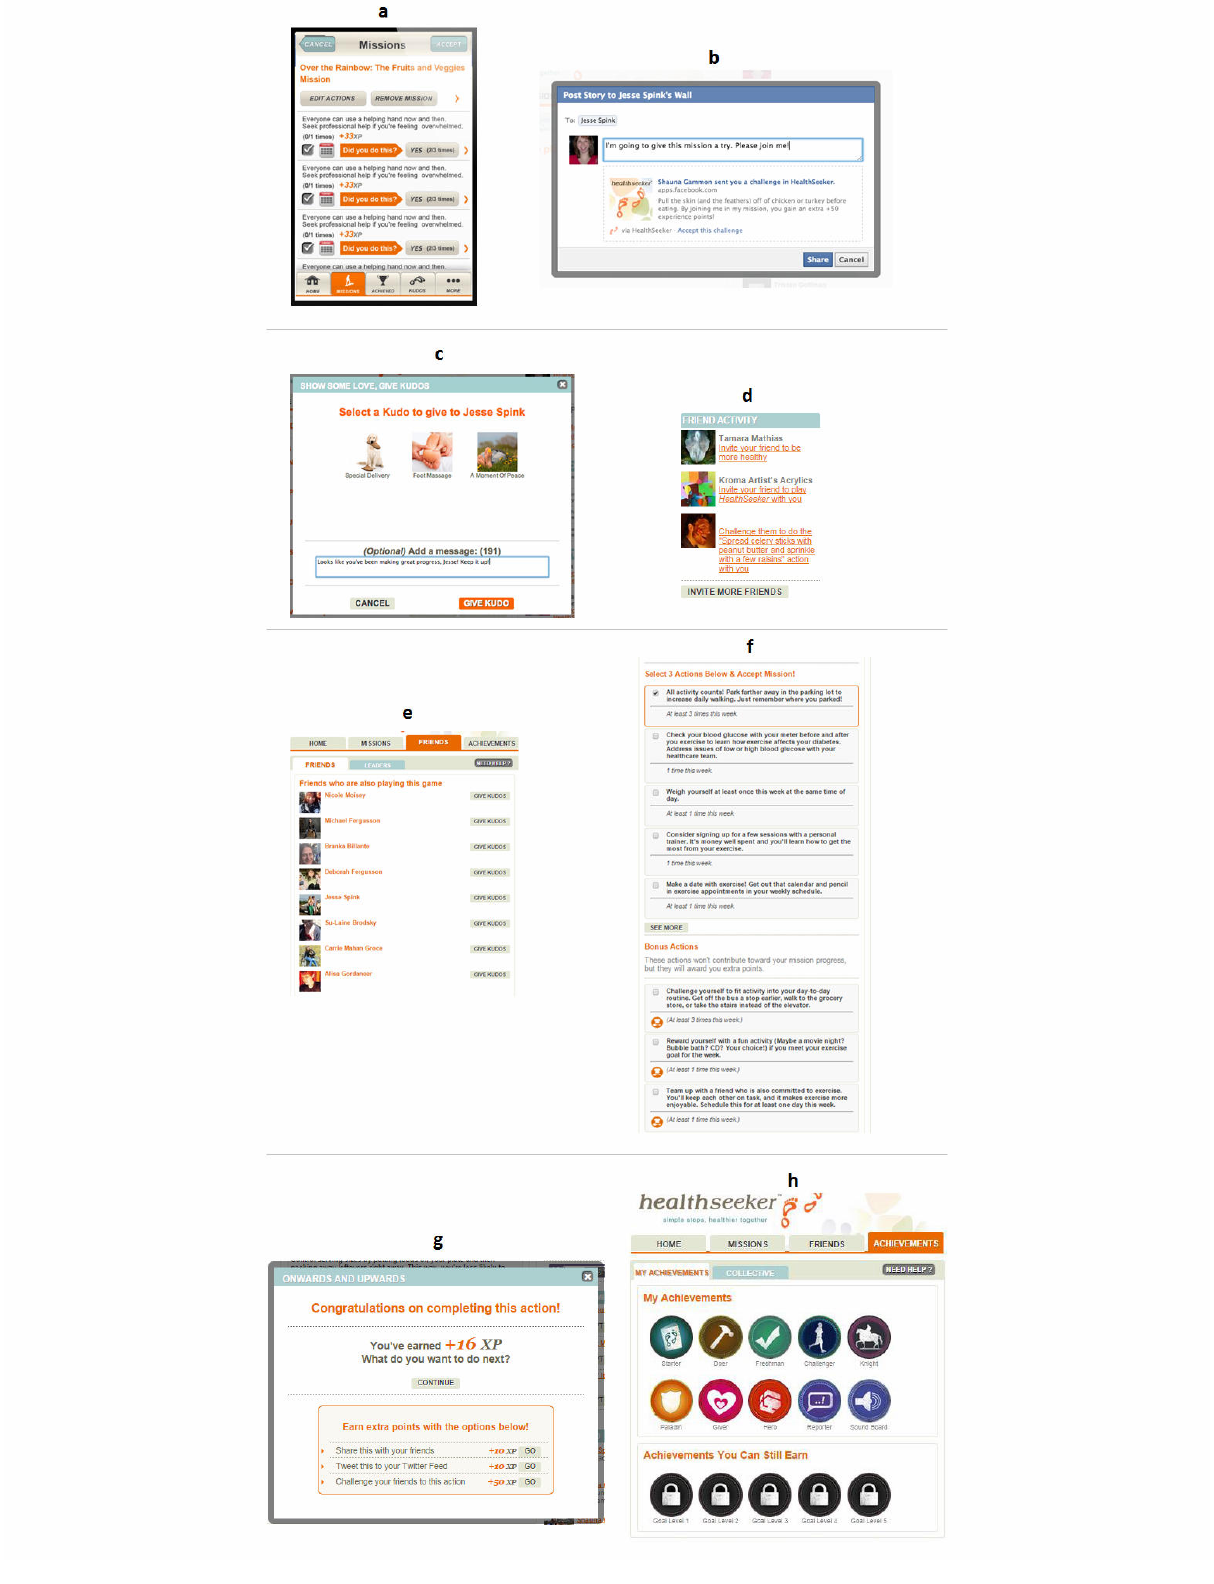
Figure 4. User-centered metrics analyzed in HealthSeeker: (a) Missions, (b) Challenges, (c) Kudos, (d) Invitations, (e) Friends, and (f)